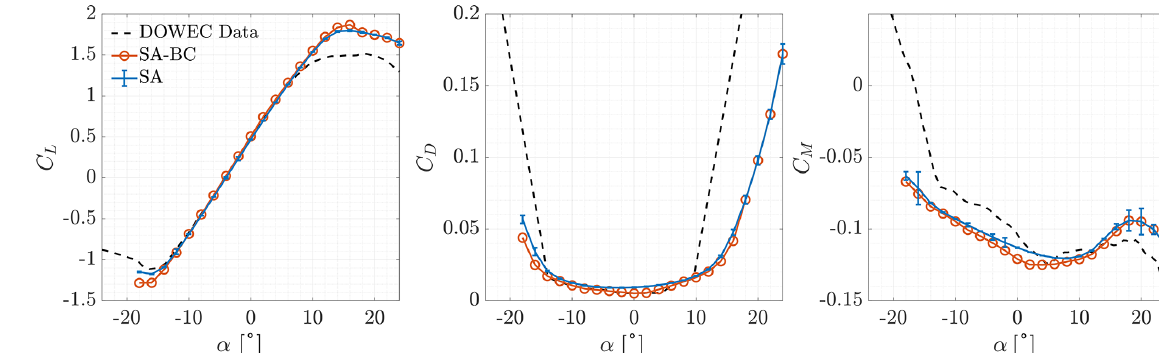
Figure 5. Aerodynamic coefficients of the NA18 airfoil.